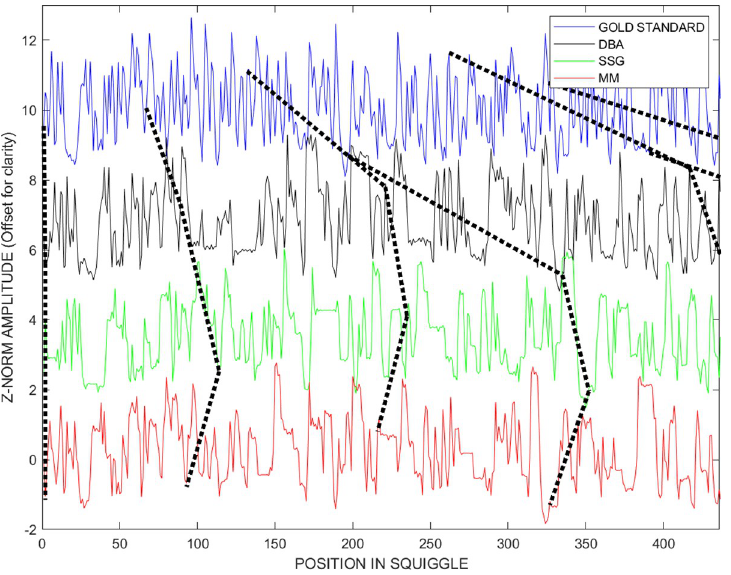
Fig 6. Displaying the first 400 points of the unwarped gold standard and the three DTWA Enolase consensus signals provides an alternative metric combining information from Figs 3 and 4. This approach allows a visualization of the warp-paths and the extent to which the DTWA algorithms retain the high entropy, squiggle amplitude levels characterizing the k-mer groups described in the original ensemble signals. Relative distortions in the consensus are revealed by the unevenly placed, non-vertical orientations of the dashed lines which join points in these un-warped signals identified as having equivalent warped path positions by the dtw()